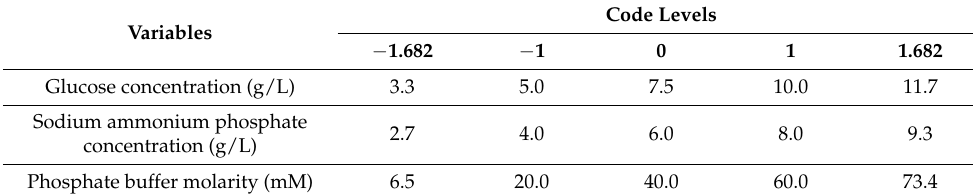
* (+) presence or ( − ) absence of the selected nutrient in the propagation medium.